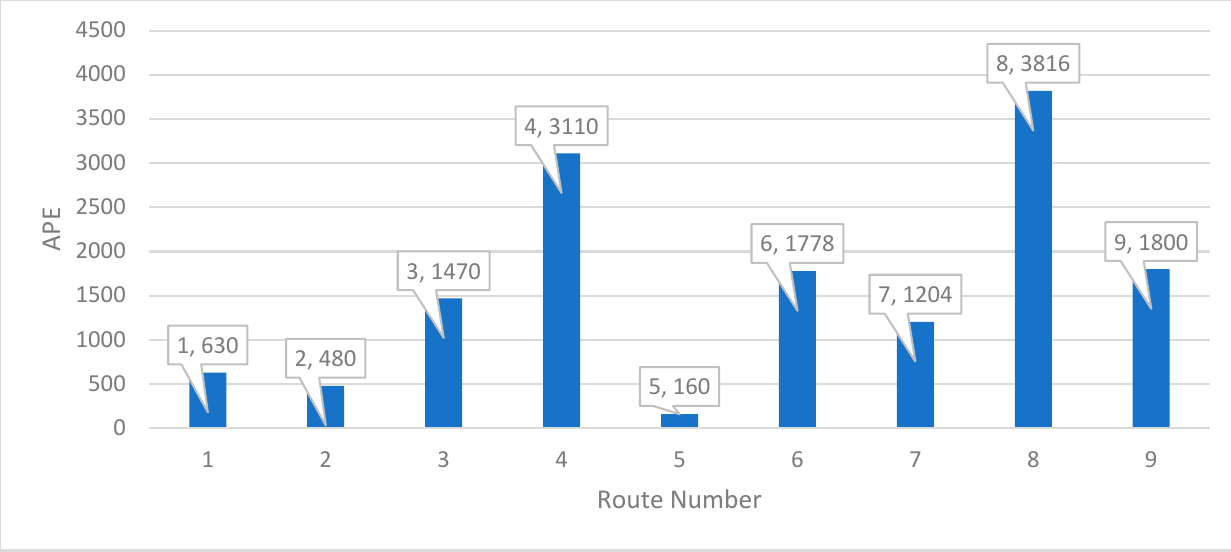
Figure 7. Performance comparison of proposed approach based on APE values.